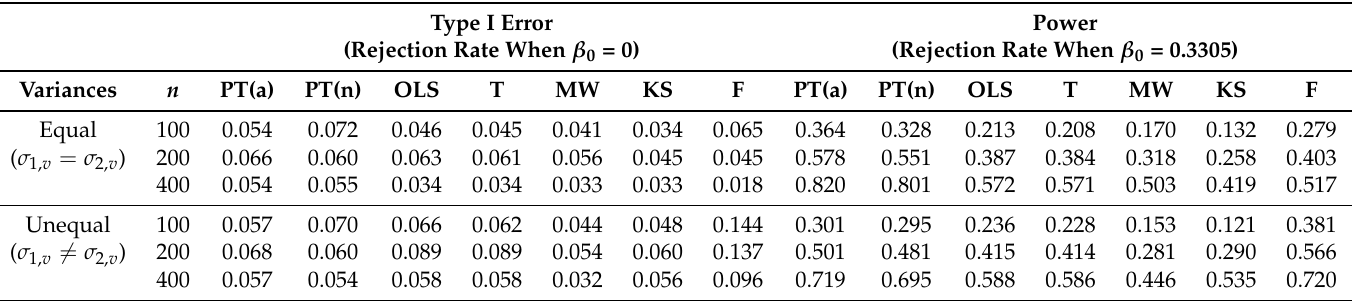
Table 3. Type I error and power of the multiple input case with equal and unequal error variances when the true production function is